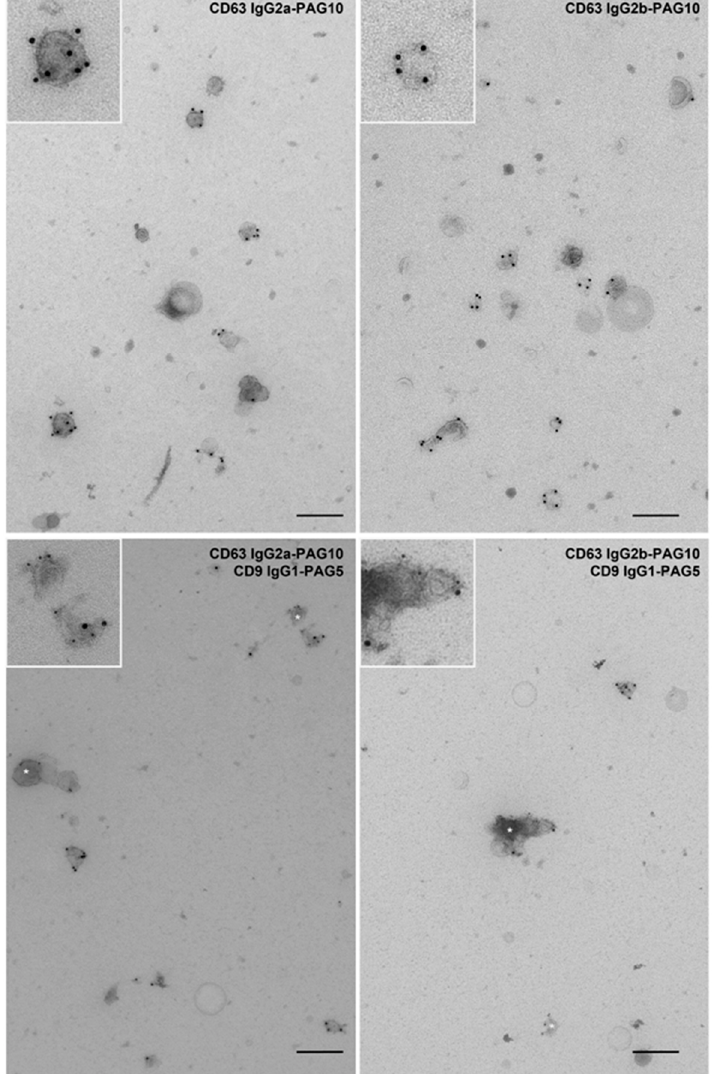
Figure 4. Immunogold labelling of extracellular vesicles with TS63a and TS63b.Top panels: TS63a or TS63b were used to label extracellular vesicles derived from MNT-1 cells. Both antibodies revealed specific and efficient labelling of a proportion of extracellular vesicles. Bottom panels: TS63a or TS63b were used to co-label extracellular vesicles derived from MNT-1 cells with anti-CD9 antibody. Both antibodies displayed distinct and specific labelling for each tetraspanin (10 nm gold particles for CD63 and 5 nm particles for CD9) and revealed subpopulations of extracellular singly labelled for either CD63 or CD9 (indicated by white star) or co-labelled for both. Inset shows a zoom-in of each panel. Scale bar: 200 nm.